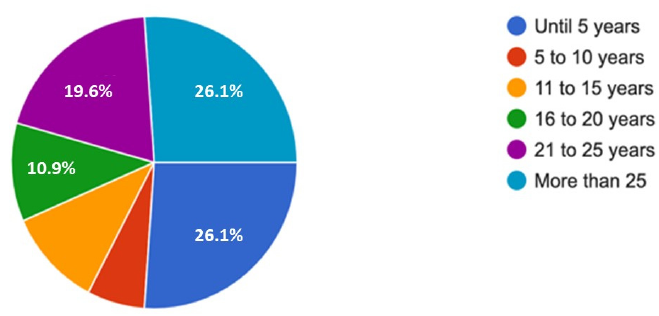
Figure 1. Gallery ages. Data source: Survey conducted by author.